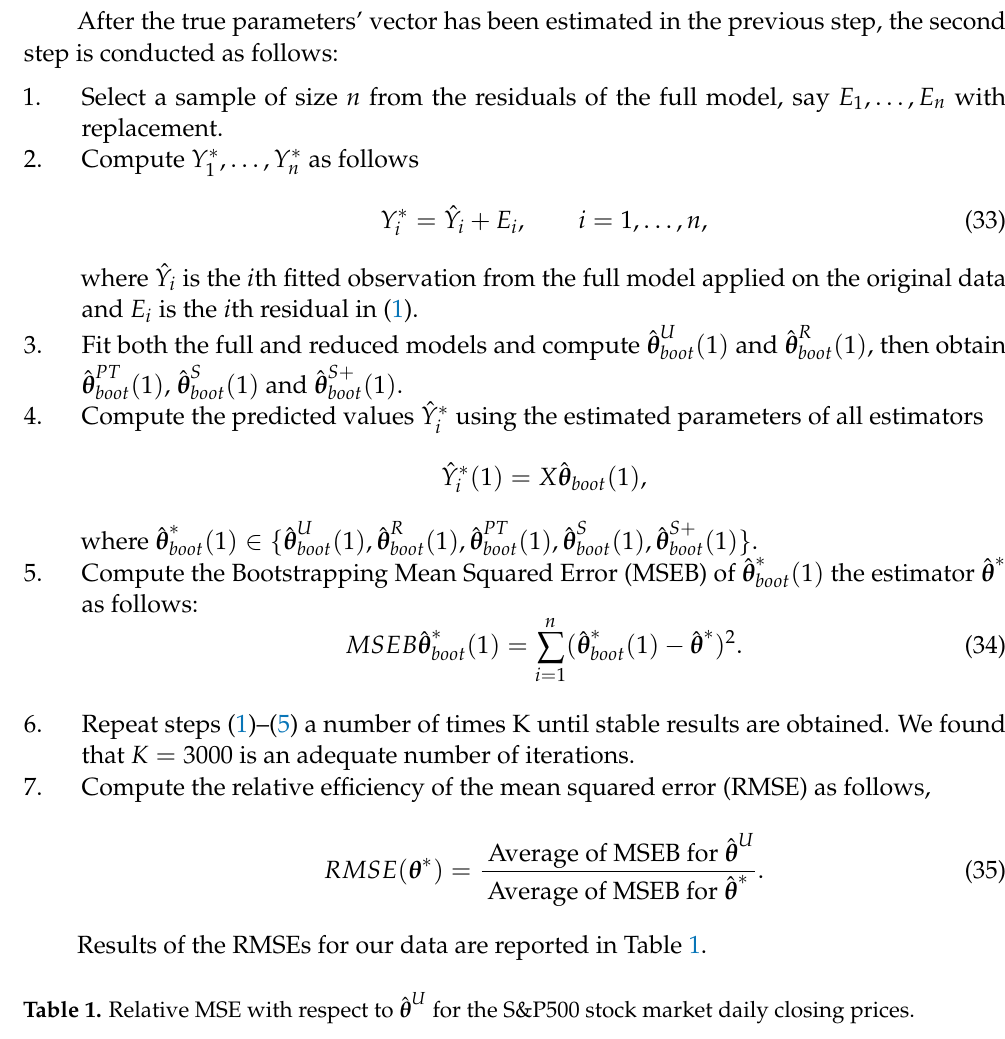
Table 1. Relative MSE with respect to ˆ θ U for the S&P500 stock market daily closing prices.